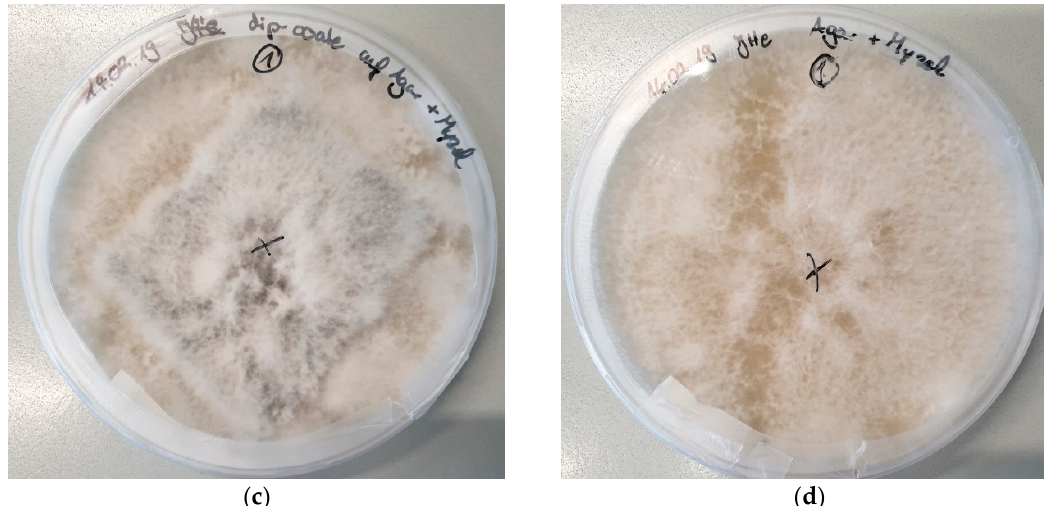
Figure 3. Pleurotus ostreatus mycelium grown on different substrates, 12 days after inoculation: ( a ) acrylic knitted fabric on agar plate; ( b ) acrylic knitted fabric dip-coated with agar; ( c ) acrylic knitted fabric dip-coated with agar on agar plate; ( d ) agar plate.